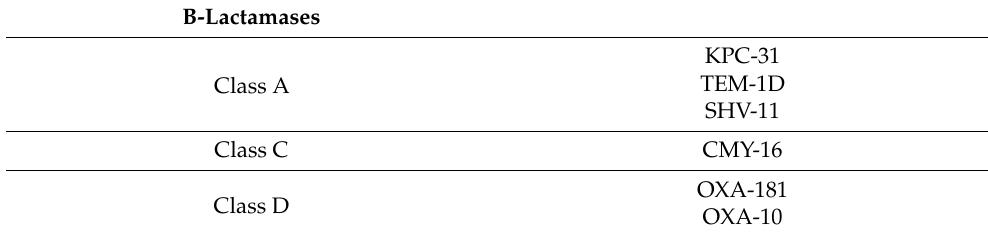
Table 3. Beta-lactamases identified by Whole Genome